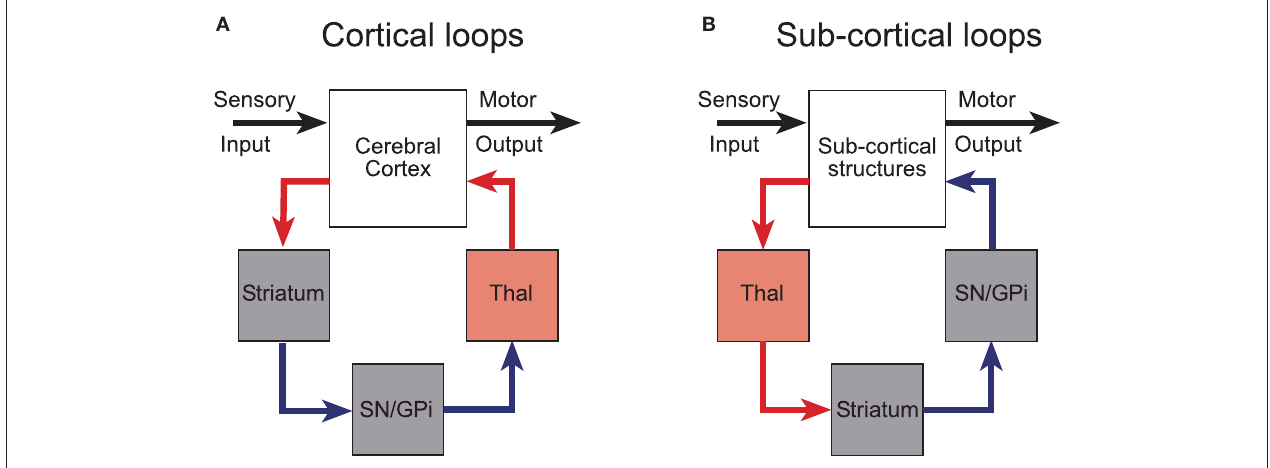
Figure 1 | Cortical and subcortical sensorimotor loops through the basal ganglia (modified with permission from McHaffie et al., 2005) . (A) The position of the thalamic relay is on the return arm of cortical loops, while for subcortical loops, the thalamic relay is on the input side. (B) Predominantly excitatory regions and connections are in red; inhibitory regions and connections are in blue. GPi, internal globus pallidus; SN, substantia nigra; Thal,